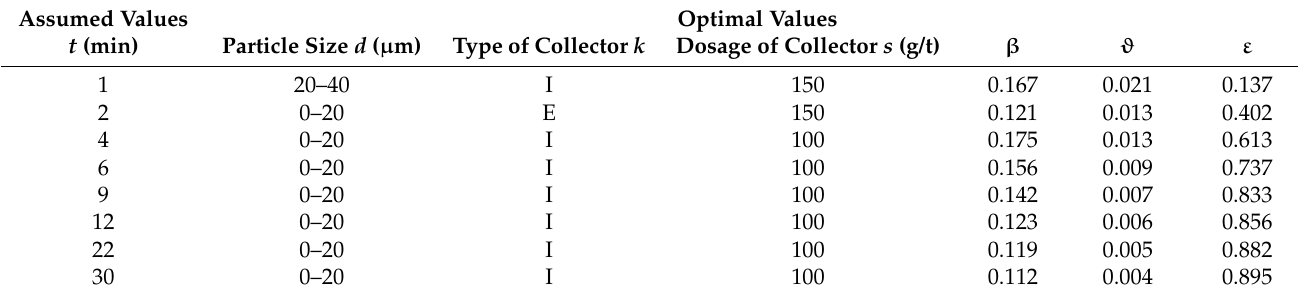
Table 9. Optimal values obtained by assumed time.